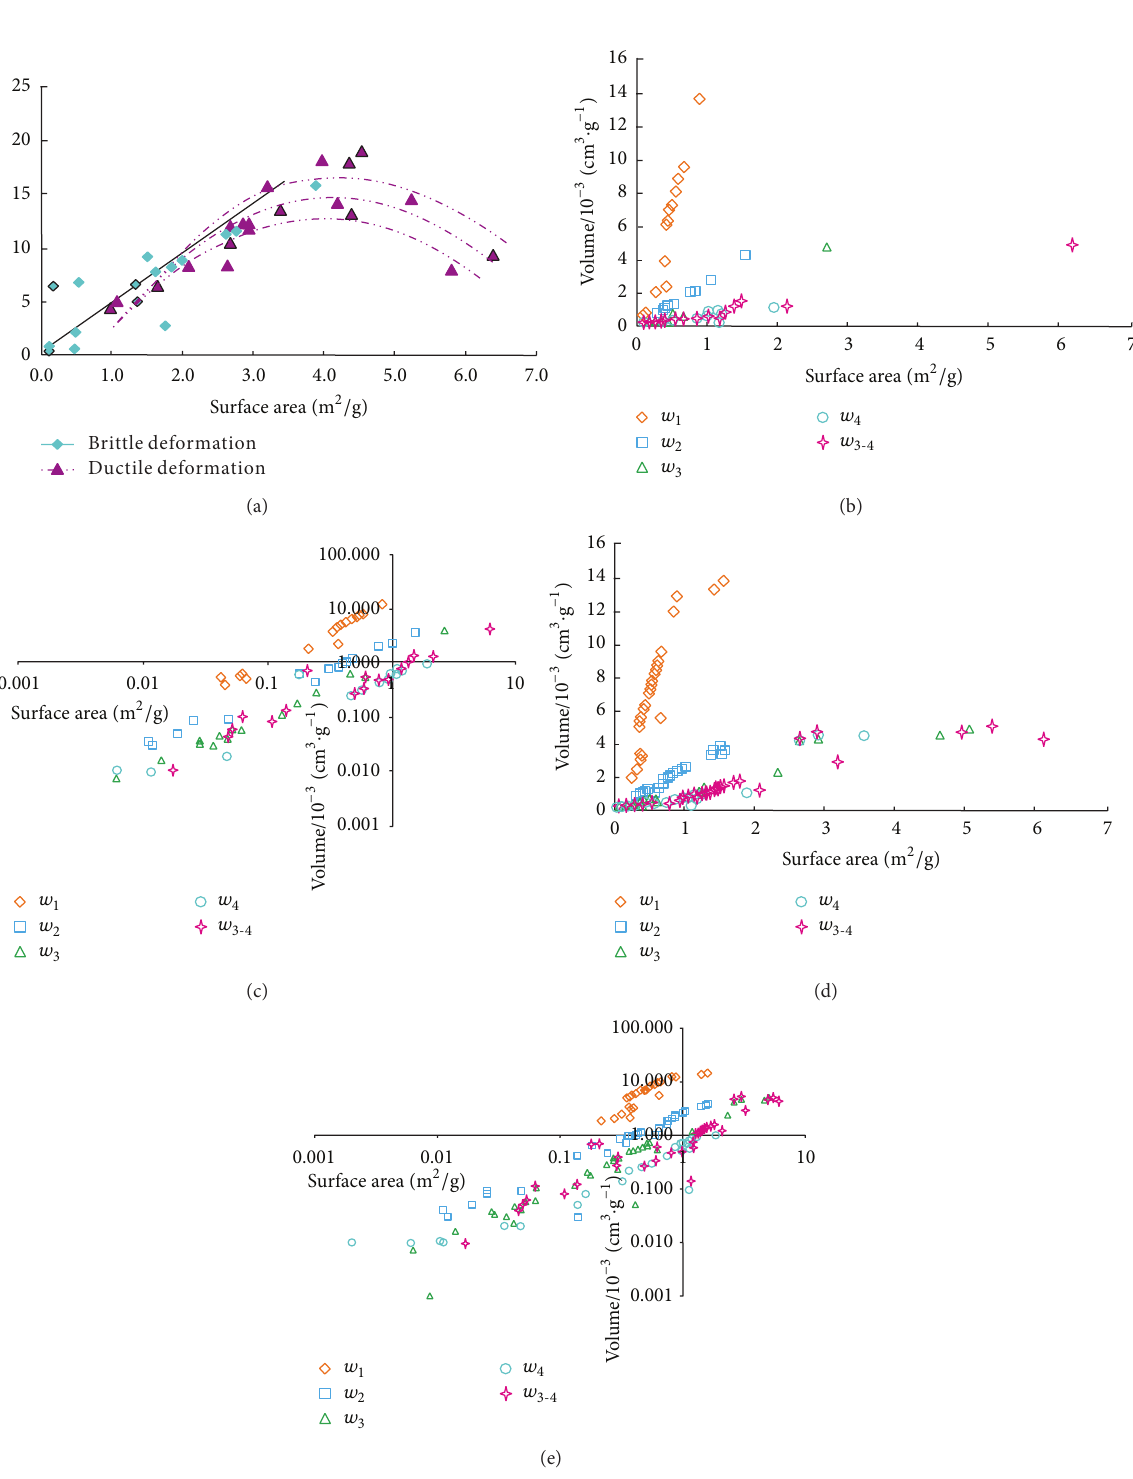
means pore size which is less than 5 nm. - 4